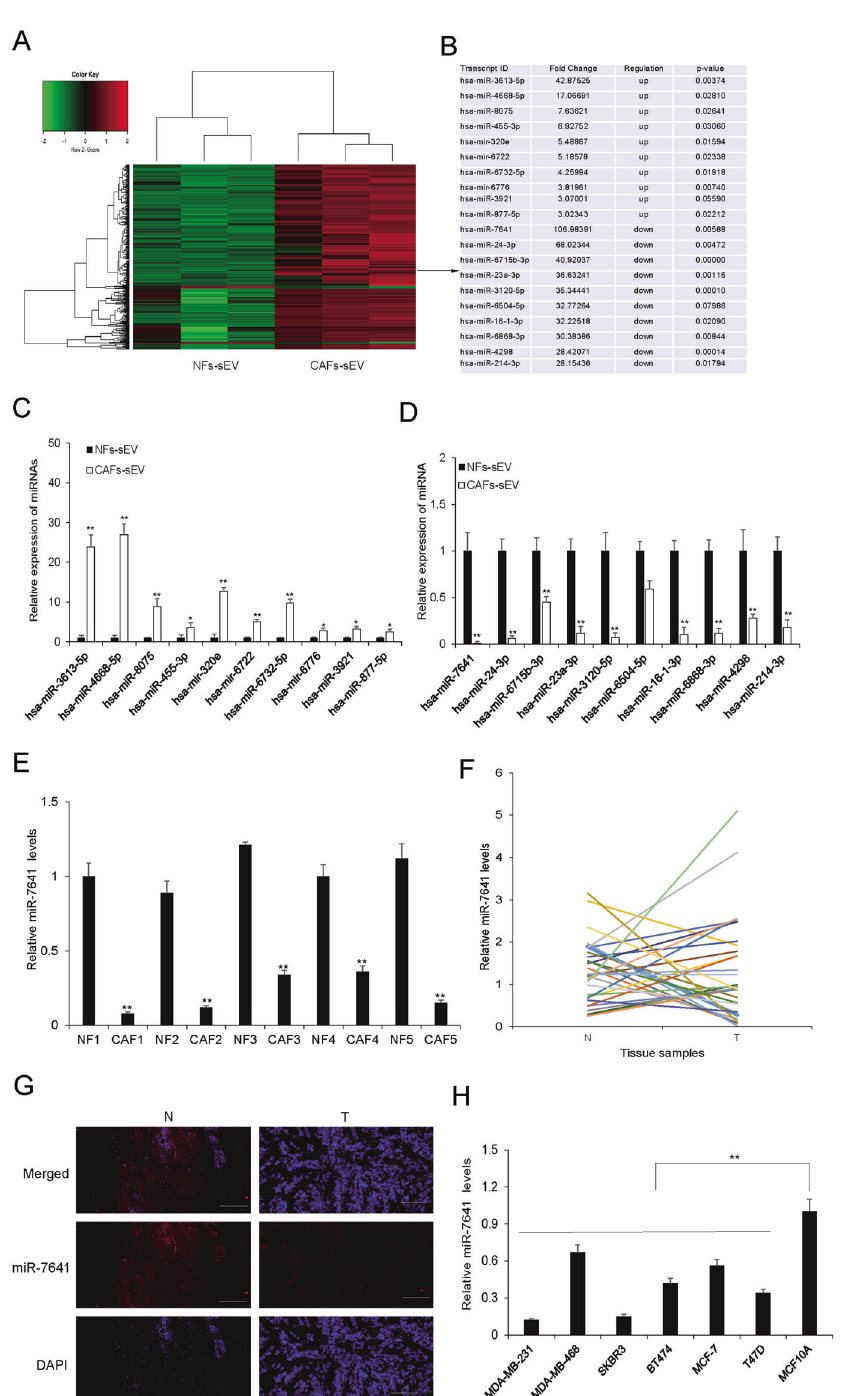
Fig. 3 MiRNA pro fi le in the sEVs from CAF and NF. A The heatmap of miRNA array assay. B The top ten up-regulated and down-regulated miRNAs were listed. C , D The top ten up-regulated or down-regulated exosomal miRNAs veri fi cation in CAFs sEVs. miRNA levels were evaluated by real-time RT-PCR. E MiR-7641 expression in fi ve paired sEVs from CAFs and NFs of breast cancer tissues. F MiR-7641 expression in breast cancer tissues and their adjacent tissues ( n = 79). N: adjacent normal tissues; T: breast cancer tissues. G MiR-7641 expression in breast cancer tissues and their adjacent tissues using FISH assay. N: adjacent normal tissues; T: breast cancer tissues. H The expression of miR-7641 in breast cancer cells with different subtypes and normal breast epithelial cells (MCF10A). * p < 0.05, ** p < 0.01.